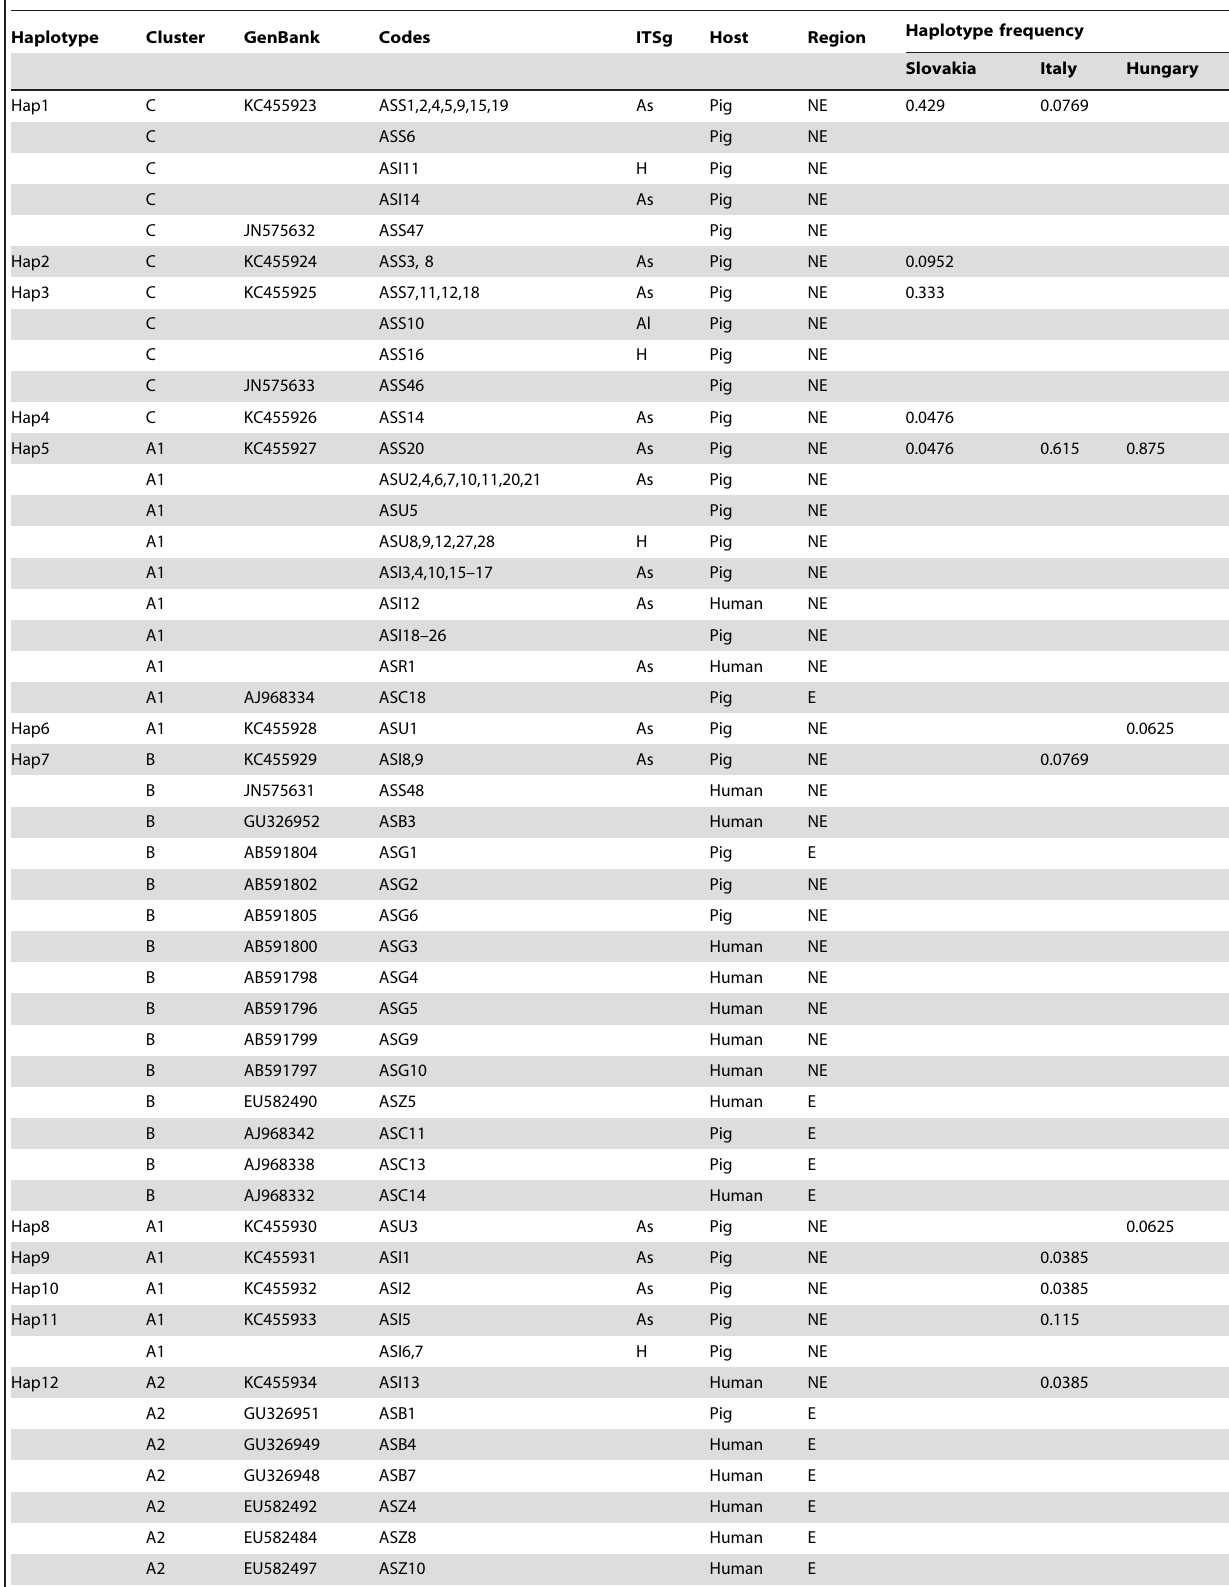
Table 2. Details of haplotypes recovered in the partial cox 1 sequence analyses.